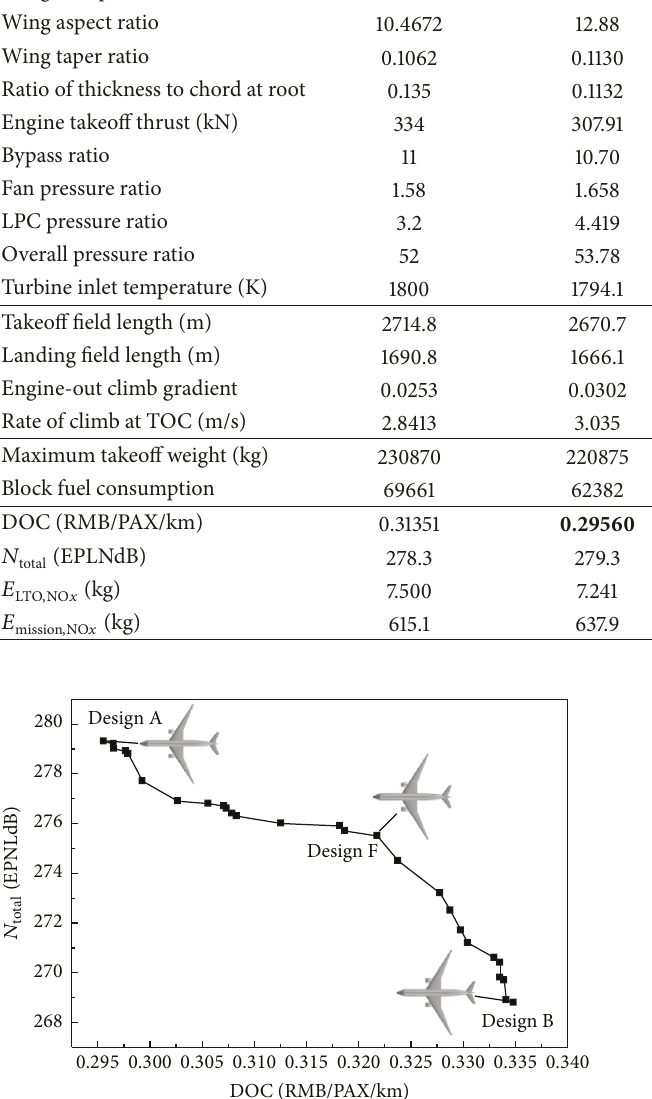
Figure 12: Pareto front for minimum DOC and 𝑁